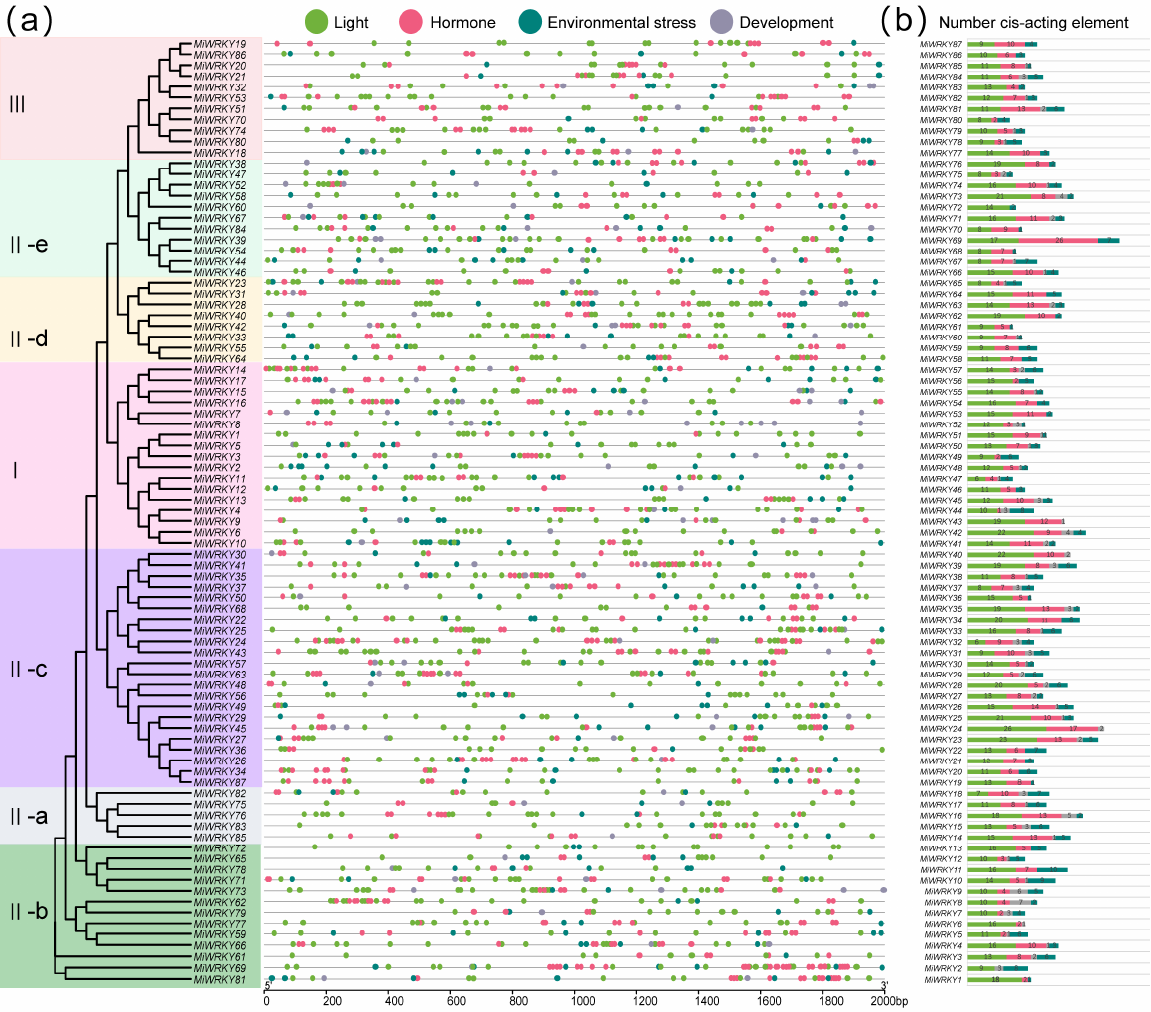
Figure 5. Analysis of cis-acting elements in the promoter region of the MiWRKY family. ( a ) The distribution of cis-regulatory elements in the 2000 bp upstream sequences of MiWRKY genes promoter region. ( b ) The numbers of cis-regulatory elements for each MiWRKY gene.